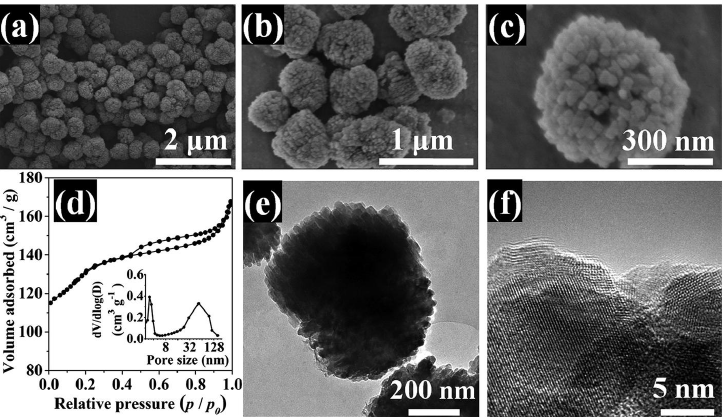
Figure 14. The morphology and textural property of N-ZSM-5: ( a – c ) SEM images under different magnification; ( d ) N 2 adsorption/desorption isotherm and BJH pore size distribution; ( e ) low magnification TEM image; and ( f ) high magnification TEM image [105]. Copyright Royal Society of Chemistry, 2016.